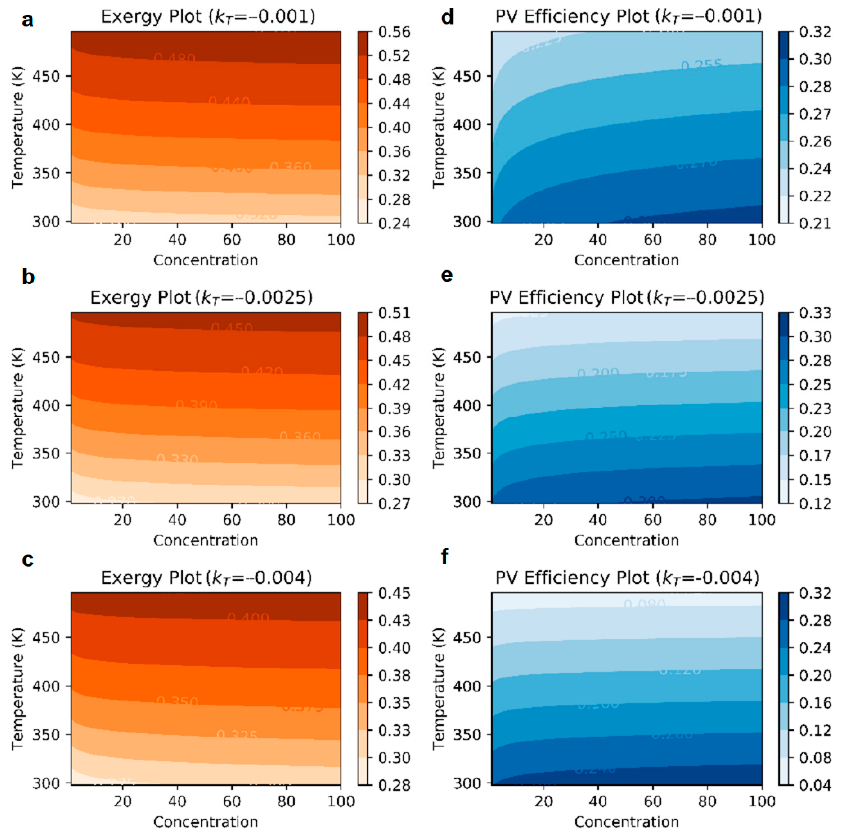
Figure 5. Upper-limit total exergy efficiency ( a – c ) and PV conversion efficiency ( d – f ) as a function of temperature & concentration, for different values of k T (0.1%/ ◦ C, 0.25%/ ◦ C, 0.4%/ ◦ C) PV cell parameters based on Alta Devices record GaAs cell [10]. For k T = 0.1%/ ◦ C, the PV cell efficiency remains above 20% up to 500K from 28% at 300K, raising the possibility of high-temperature CPVT collectors.